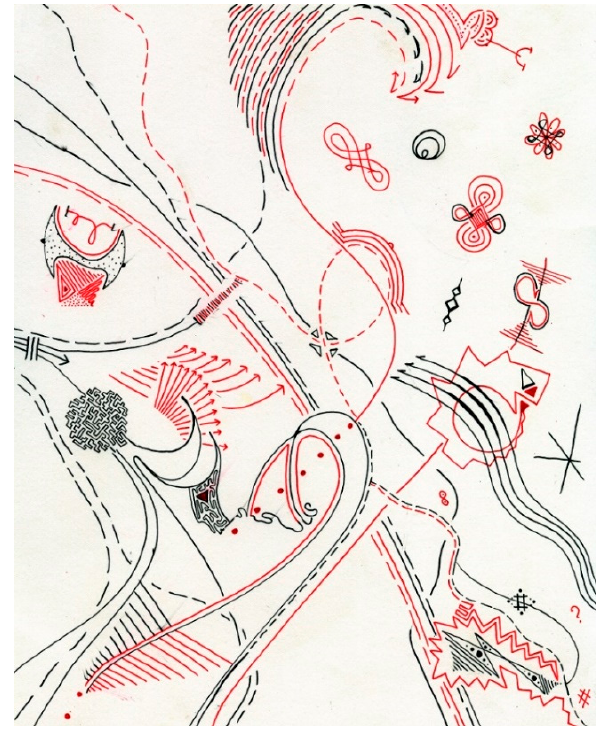
Figure A7. “Wave”. Red and black pen, white paper. Drawing made by authors. License: Creative Commons Attribution-NonCommercial 4.0 International.